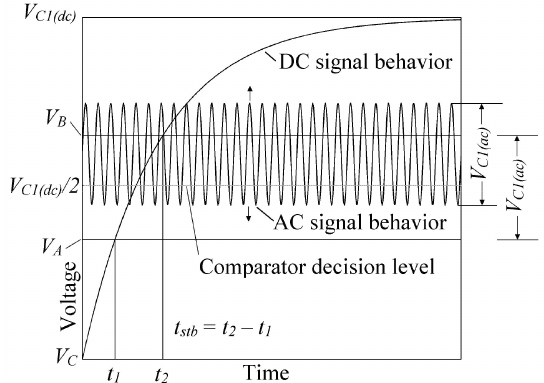
Figure 8. The AC and DC signal behavior of the flame detecting circuit. The AC signal is attenuated by the passive integrator circuit, whereas the DC signal follows an exponential behavior. The comparator’s decision level is V C 1( dc ) /2. The comparator’s decision level was chosen V C 1( dc ) /2 in order to reduce the noise